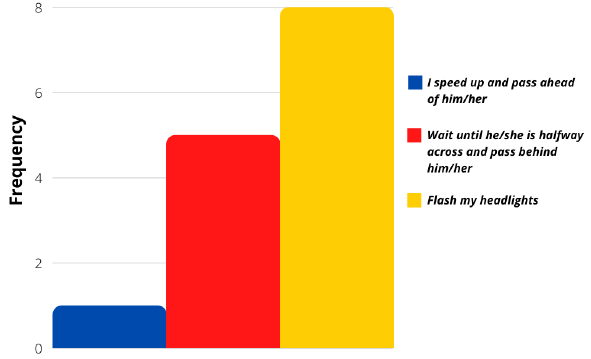
Figure 10. Question 52 results.